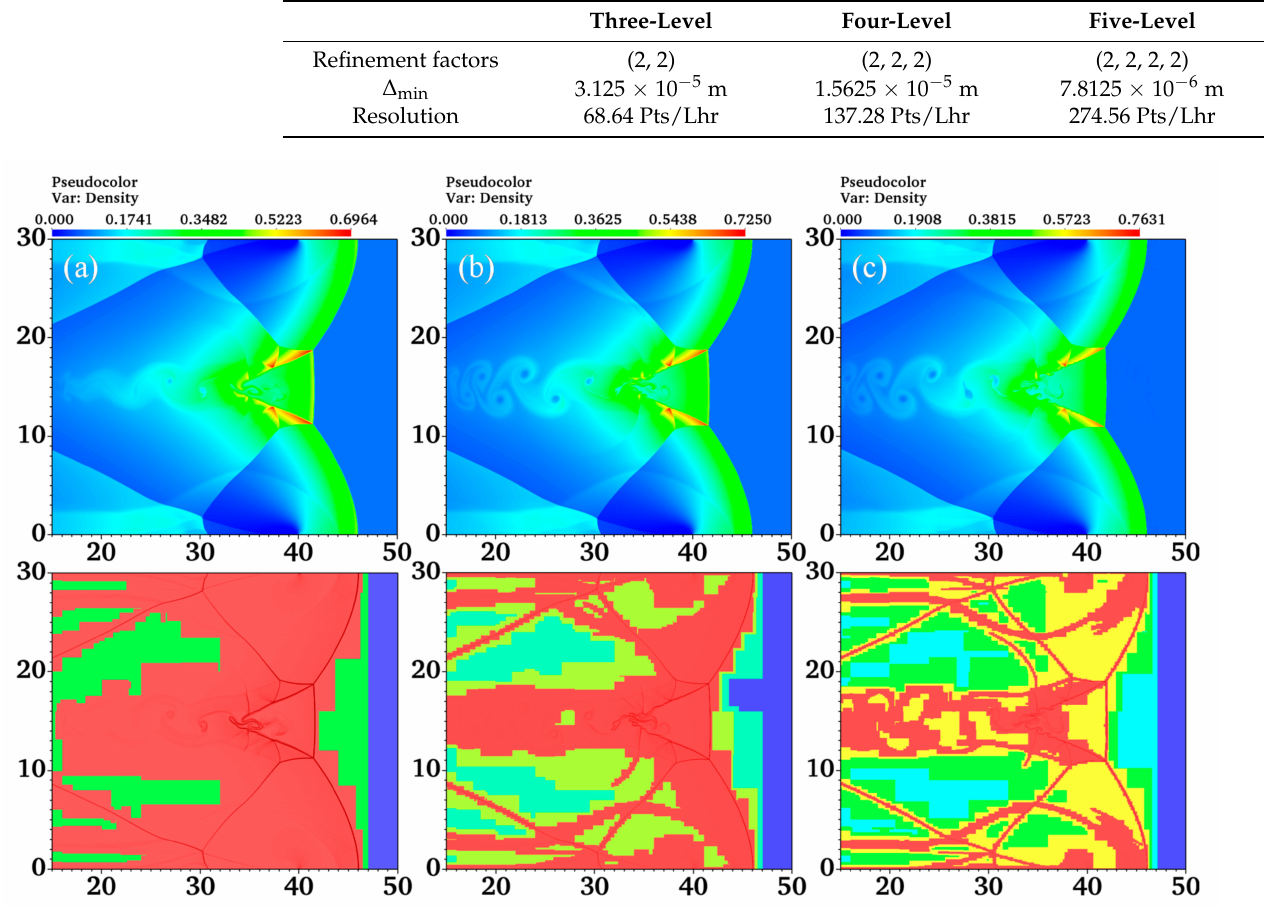
Table 3. Mesh refinement parameters.